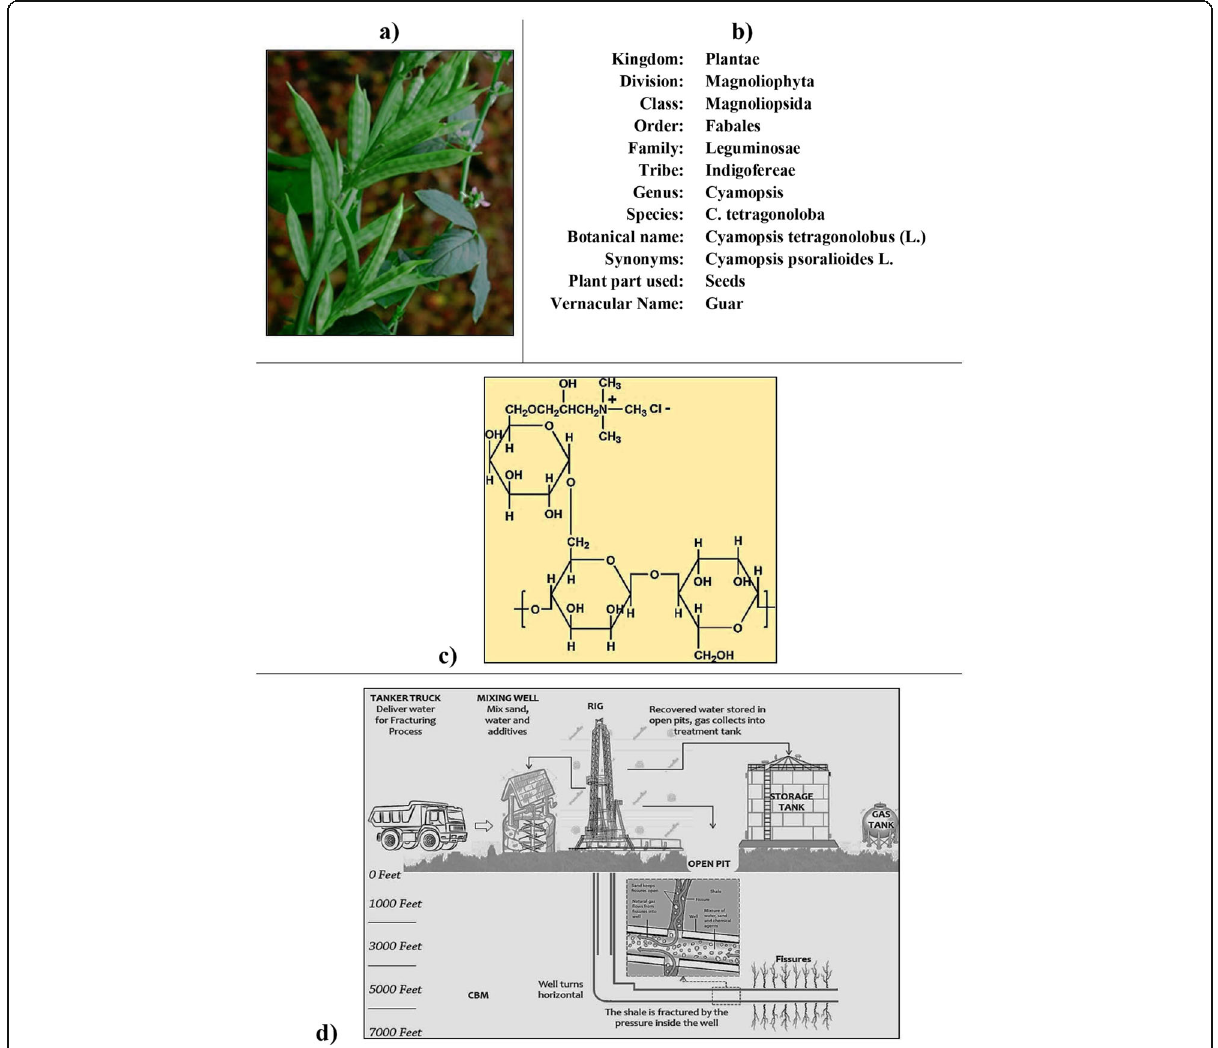
Fig. 1 a Guar gum plant. b Guar scientific classification. c Chemical structure of guar gum. d Hydraulic fracturing